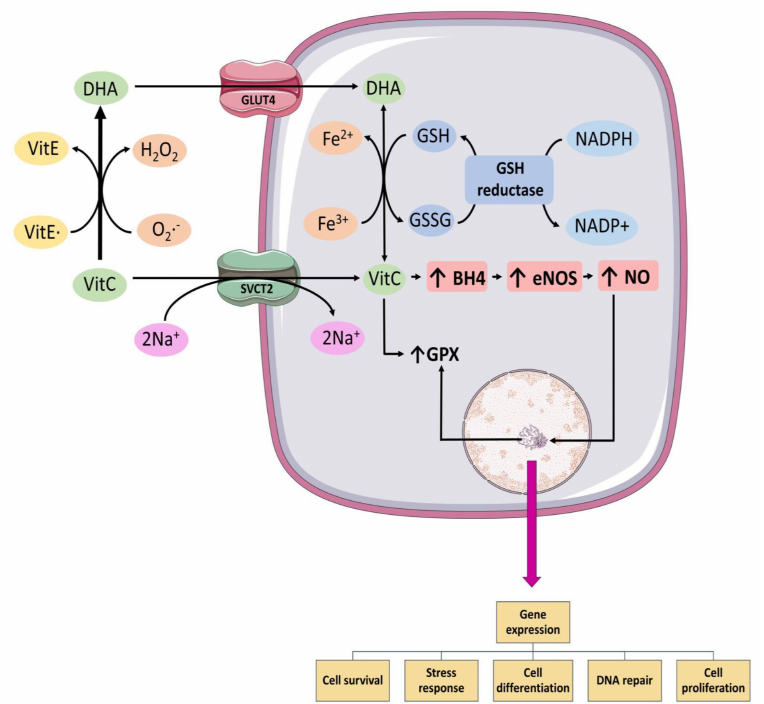
Figure 3. Mechanism of Vit C uptake and its effects in the cell: Reduced form of Vit C is transported through sodium-dependent transporter (SVCT2) and oxidized form, dehydroascorbic acid (DHA), is transported through GLUT4. Inside the cell, DHA is reduced back to Vit C. Vit C increases levels of tetrahydrobiopterin (BH4), levels which are a cofactor for endothelial nitric oxide synthase (eNOS) coupling and important for nitric oxide (NO) synthesis. AA, ascorbic acid; BH4, tetrahydrobiopterin; DHA, dehydroascorbic acid; eNOS, endothelial nitric oxide synthase; GLUT 4, type 4 glucose transporter; GPX, glutathione peroxidase; NO, nitric oxide; SVCT2, sodium-dependent vitamin C transporter 2; Vit E, α -tocopherol: Vit E . , α -tocopheroxyl